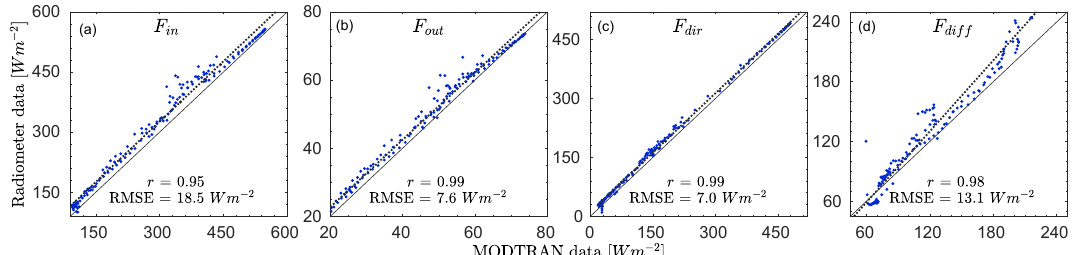
Figure 3. Comparison of model-derived and measured irradiances, in particular incoming F in (a) , outgoing F out (b) , direct F dir (c) , and diffuse F diff (d) surface fluxes on 9–11 July 2015. The solid black lines refer to the perfect fir, dotted black lines to a linear fit, r refers to the Pearson correlation coefficient, and RMSE represents the root mean square